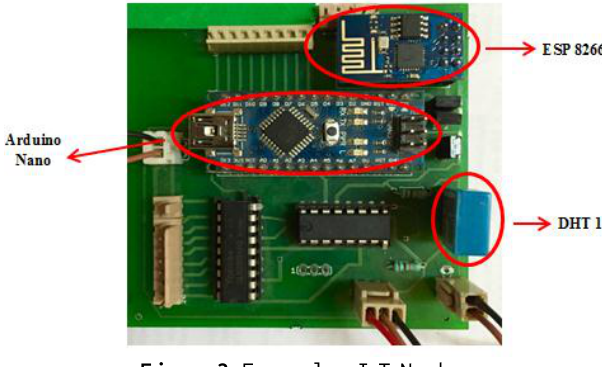
Figure 3. Exemplary IoT Node